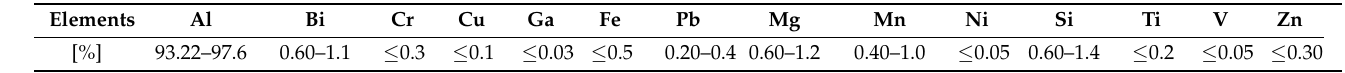
Table 1. % Weight composition in